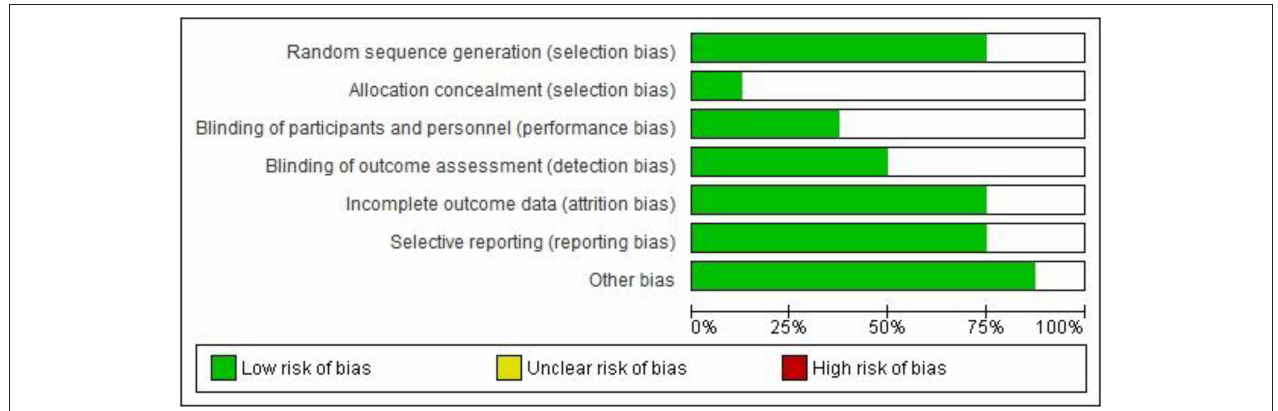
FIGURE 2 | Risk of bias graph: review the authors’ judgments on each risk of bias item presented as percentages across all included studies. Created using Software Review Manager